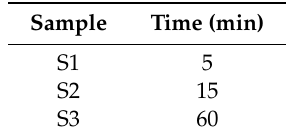
Table 1. Immersion times of the samples in an electroless plating bath.